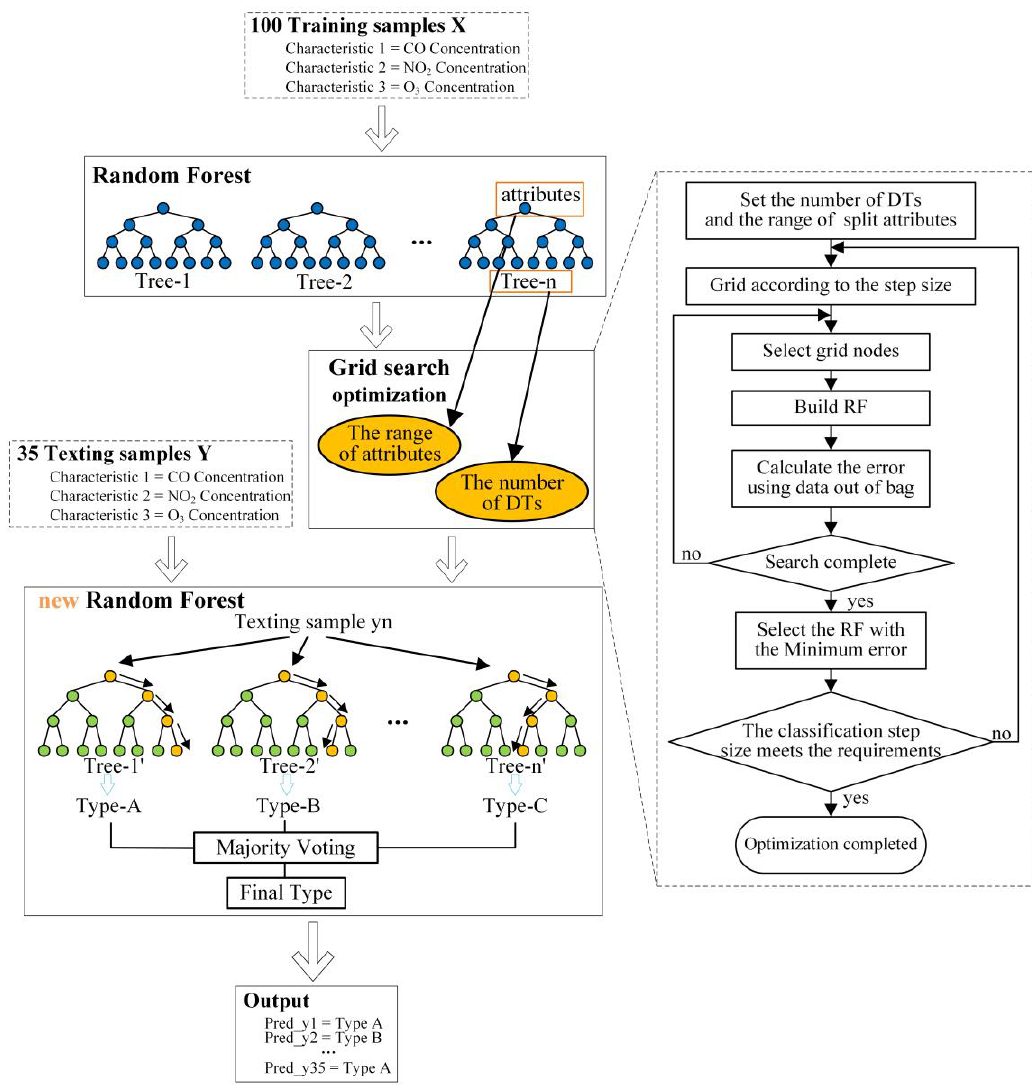
Figure 4. The framework of the algorithm and the optimization process.